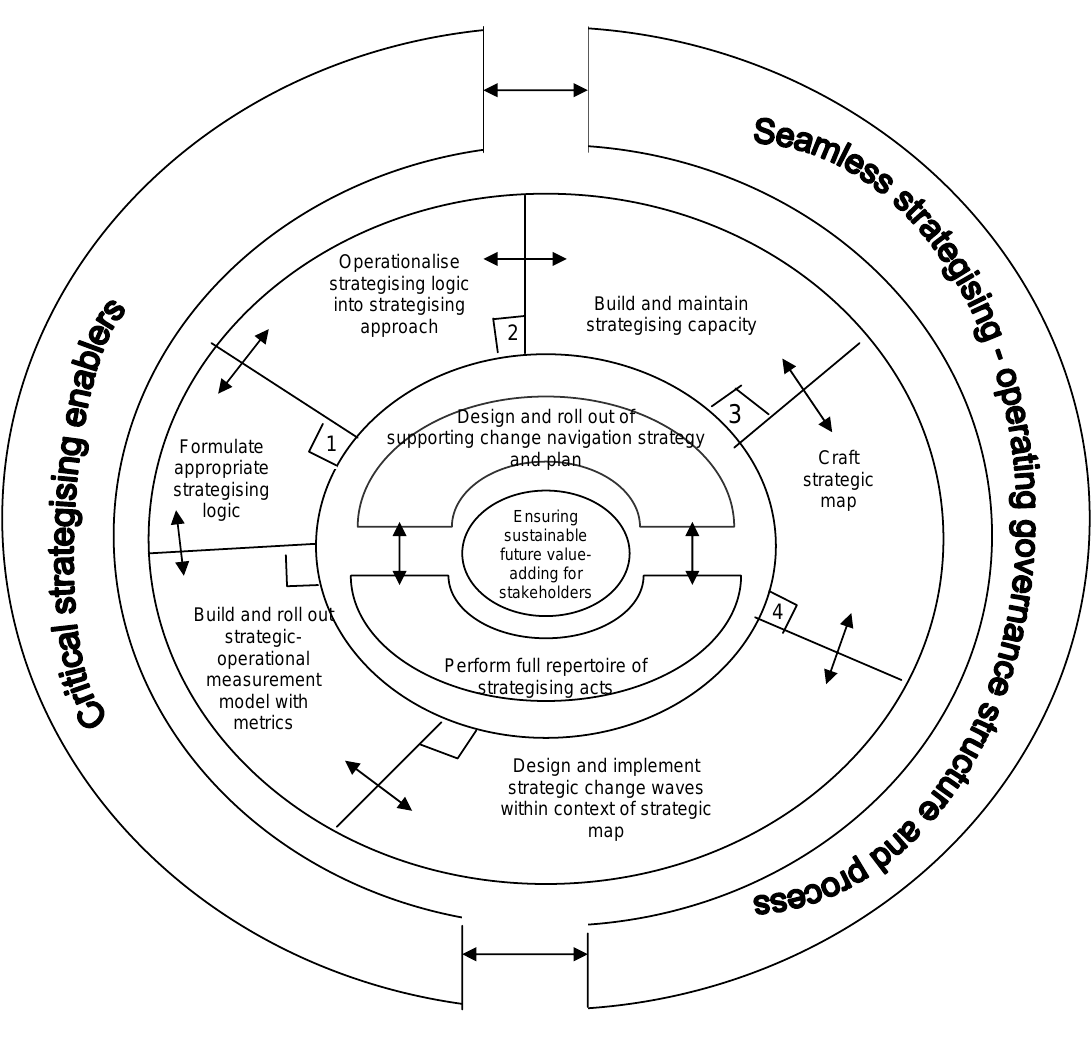
Figure 6: A proposed overall strategising approach suitable to a hyperturbulent and hyperfluid